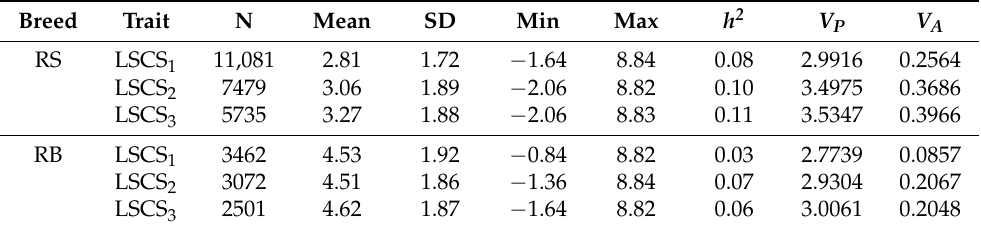
Table 1. Descriptive statistics for somatic cell score (SCS) in Romanian dairy cattle. Breed Trait N Mean SD Min Max h 2 V P V A RS LSCS